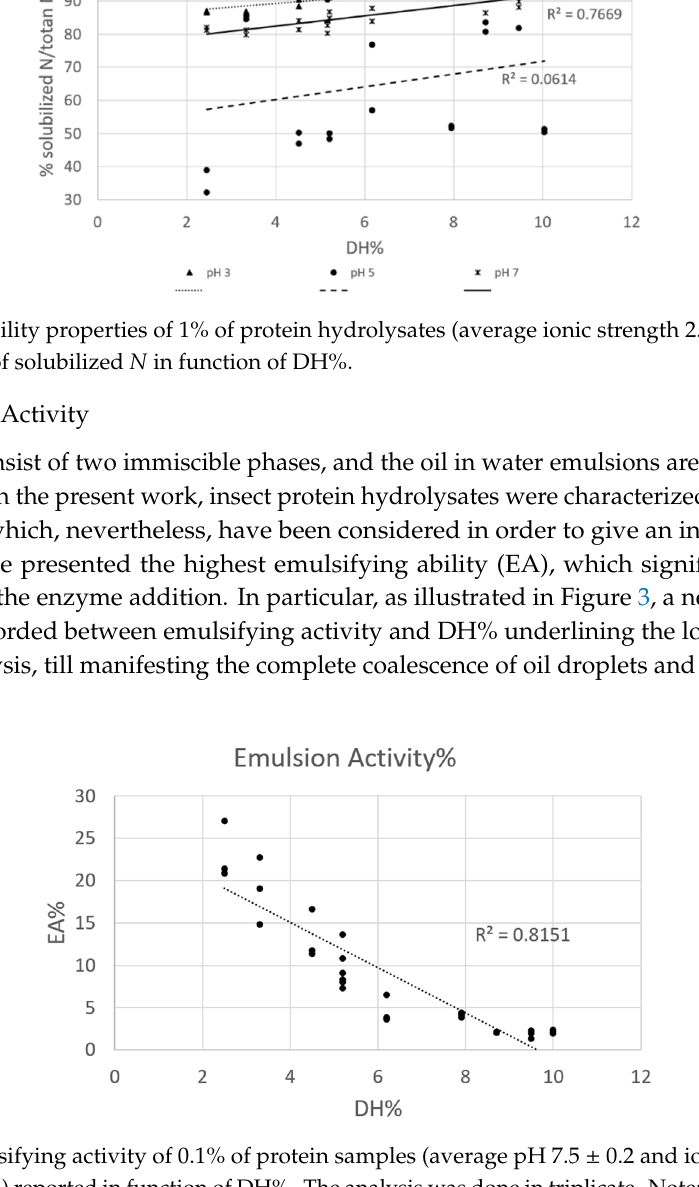
Figure 3. Emulsifying activity of 0.1% of protein samples (average pH 7.5 ± 0.2 and ionic strength of 1.3 ± 0.1 mS / cm) reported in function of DH%. The analysis was done in triplicate. Note: emulsification layers were incomplete—values only given as indication of a trend, not for direct comparison with literature data.